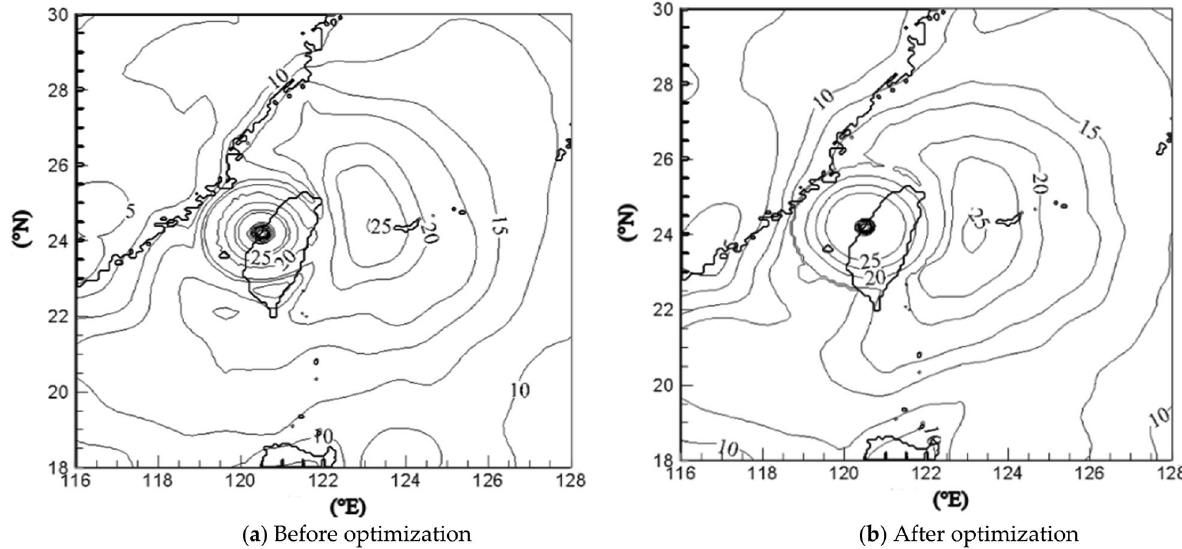
Fig. 3 Contour curves of wind speed before and after optimization